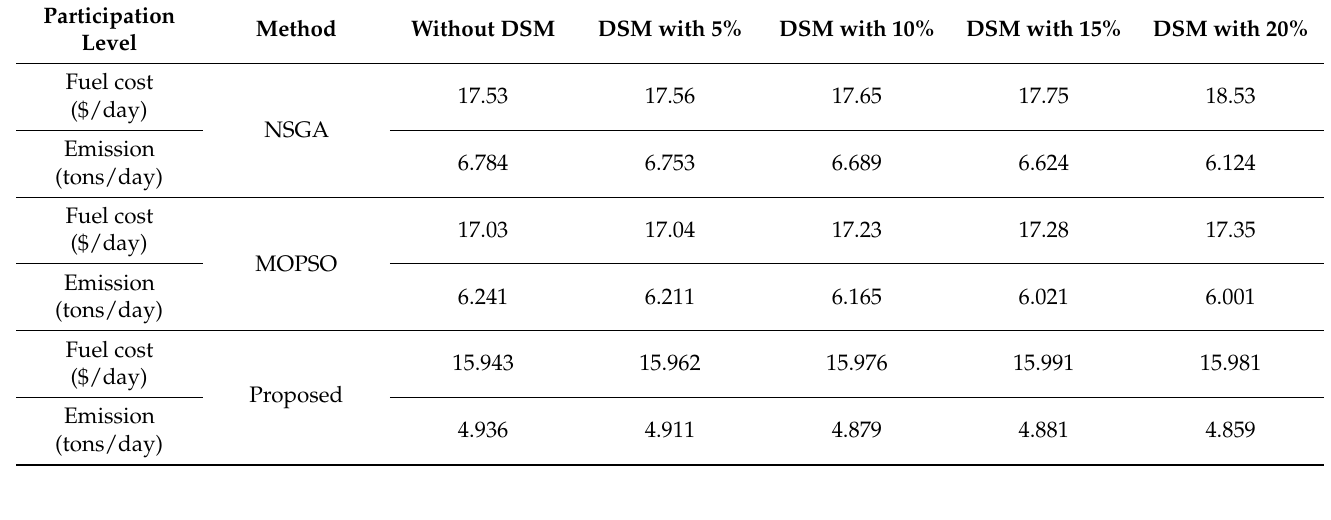
Table 3. Dynamic emission distribution by various levels of DSM participation.